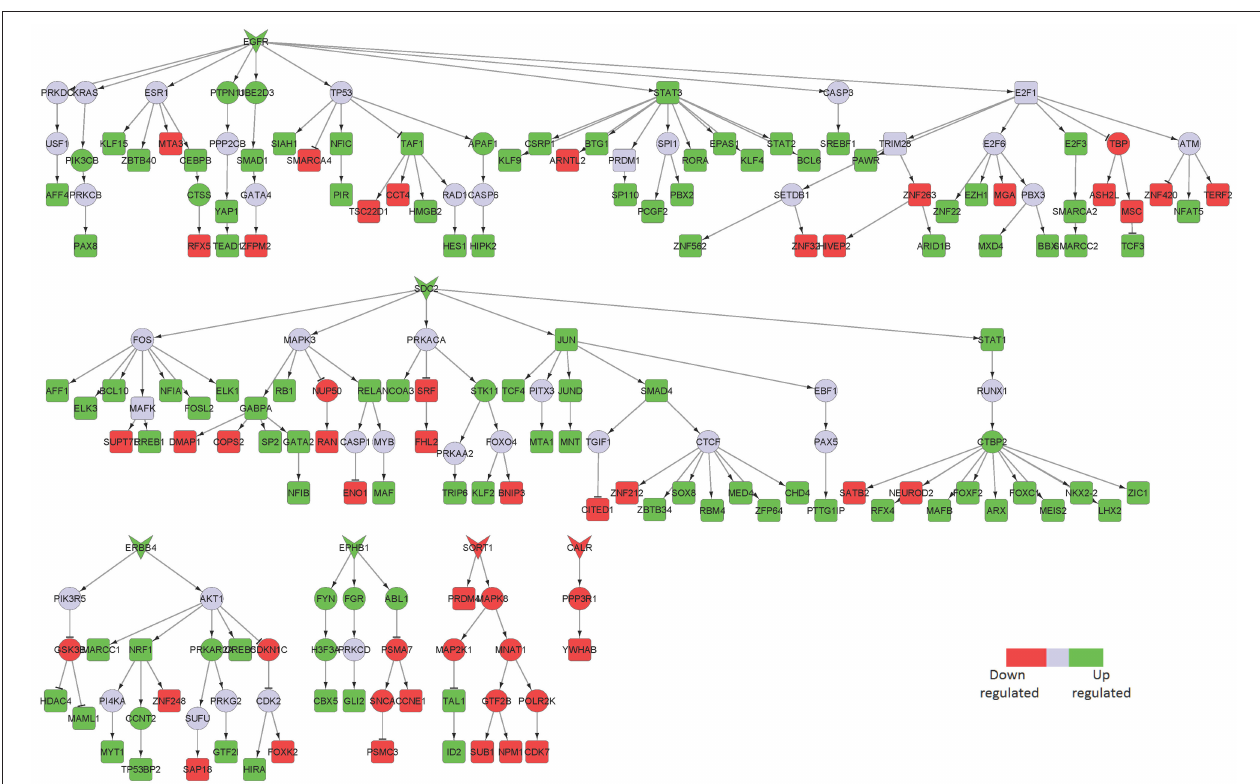
FIGURE 4 | Key signaling networks identified for the middle temporal gyrus. The figure shows five key signaling subnetworks controlled by EGFR, SDC2, ERBB4, EPHB1, SORT1, and CALR for middle temporal gyrus with known role in AD. EGFR controlled subnetwork consisted of 39 up- and 15 downregulated TFs, SDC2 subnetwork consisted of 39 up- and 12 downregulated TFs, ERBB4 subnetwork consisted of 9 up- and 3 downregulated TFs, EPHB1 subnetwork consisted of 2 up- and 2 downregulated TFs, SORT1 consisted of 2 up- and 4 downregulated TFs, CALR consisted of one downregulated TF. Further, subnetworks controlled by EGFR, SDC2, ERBB4, EPHB1 represent constantly activated signaling while the ones controlled by SORT1 and CALR represent constantly inhibited signaling pathways. The figure legends are the same as that in Figure 2 . Supplementary Figure 3 contains the other subnetworks identified for middle temporal gyrus that did not have known role in AD.